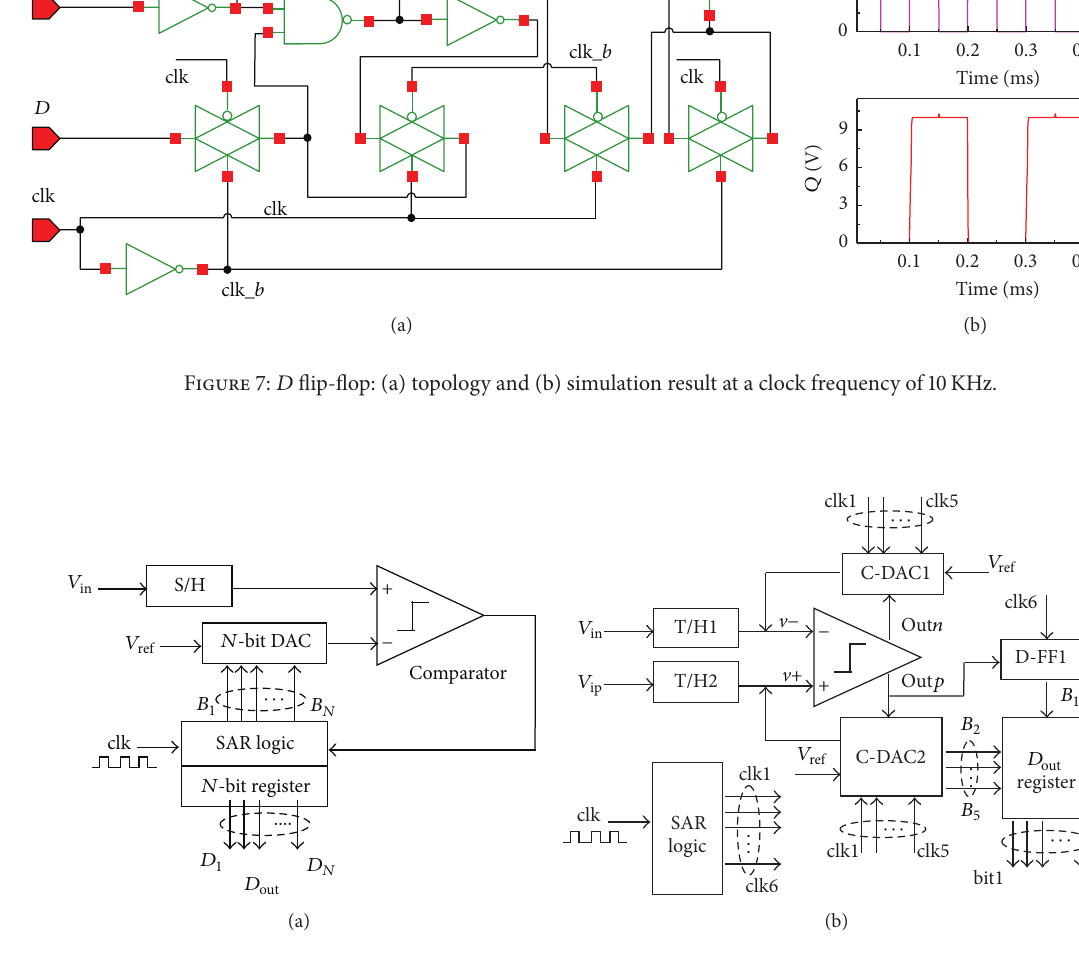
Figure 8: (a) Conventional structure of a SAR ADC. (b) Simplified structure of 6-bit SAR